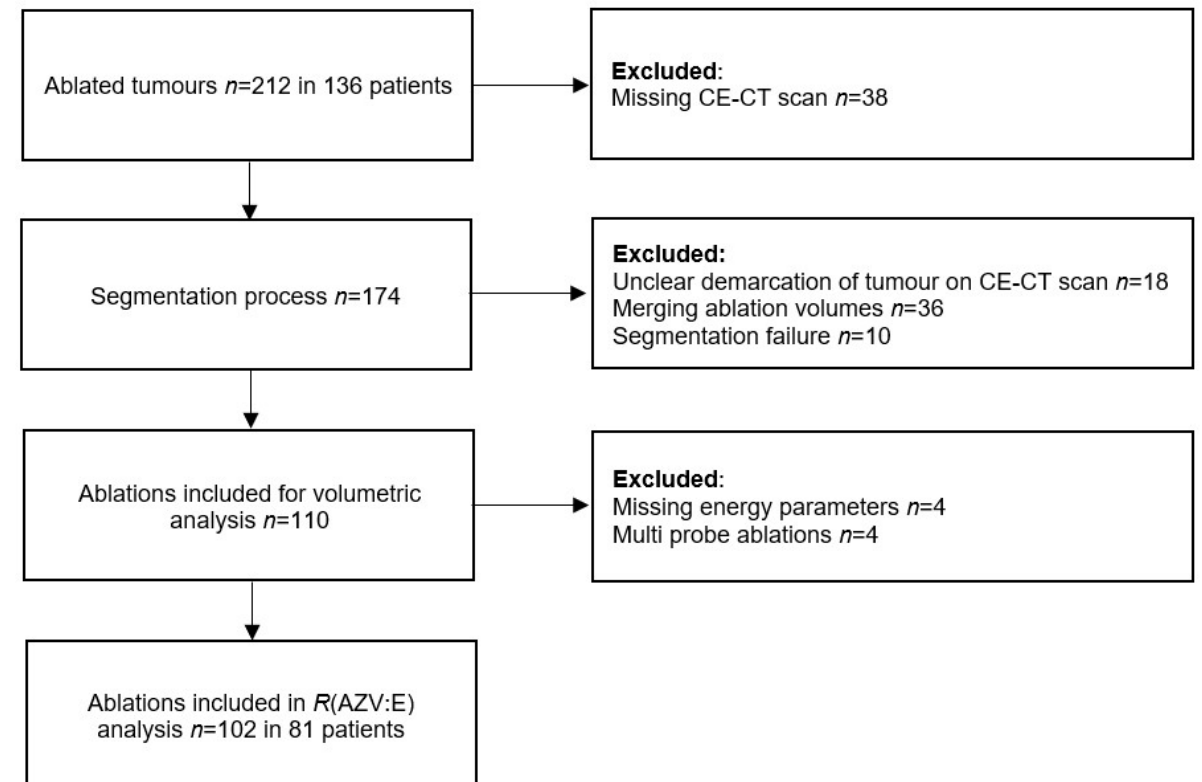
Figure 1. Flowchart of ablations included for volumetric analysis of ratio between ablation zone volume and applied energy, R (AZV:E). CE-CT: contrast-enhanced computed tomography; R (AZV:E): ratio between ablation zone volume and applied energy.